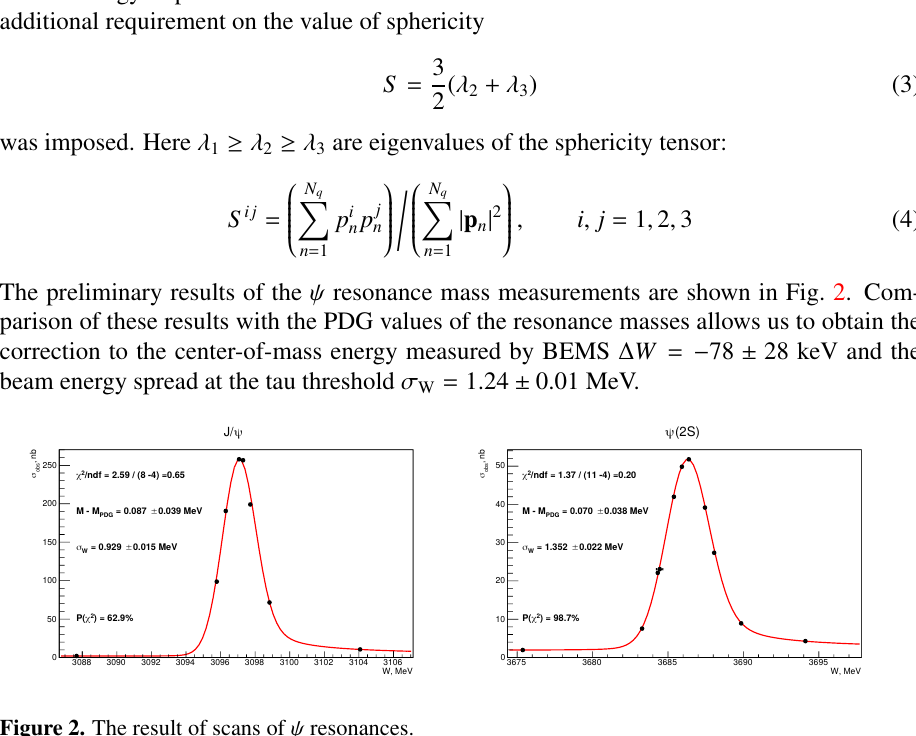
Analysis of the process e + e − → τ + τ − is based on τ pair decays to e µ , e π , e ρ , µπ , µρ , πρ , ee , µµ , ππ . Thus events with two oppositely charged tracks originated from the interaction point were selected. The tracks must have | cos θ | < 0 . 93 to get good momentum measurement in the drift chamber. The dE / dx , time-of-flight and muon systems were used for particle